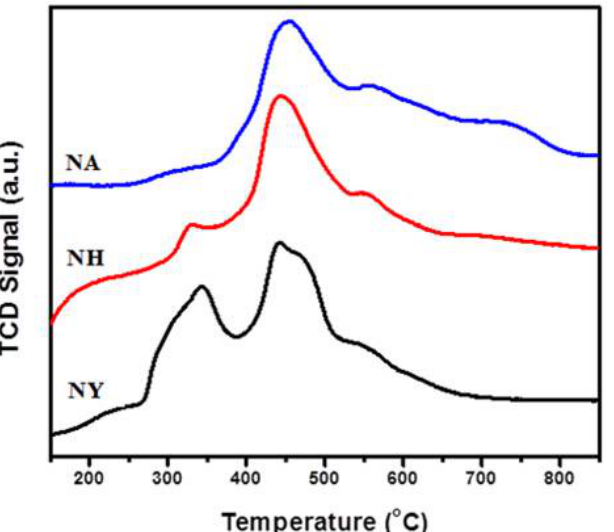
Figure 5. TPR profiles for Ni supported on alumina (NA), Ni supported on Y-zeolite (NY), and Ni supported on H-ZSM-5 (NH) fresh catalysts .